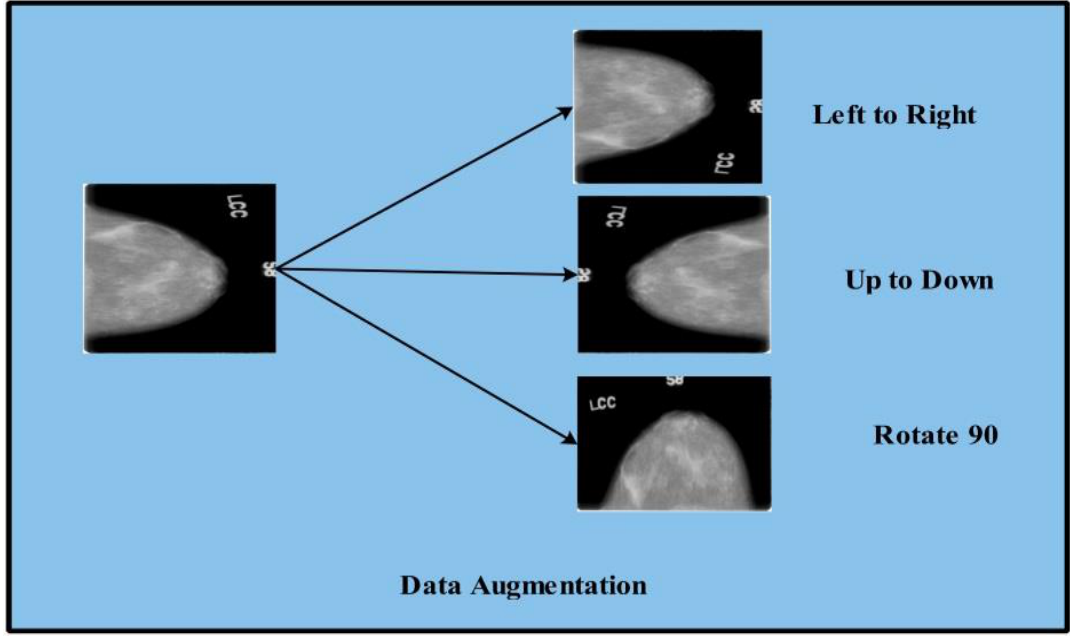
Figure 5. Data augmentation